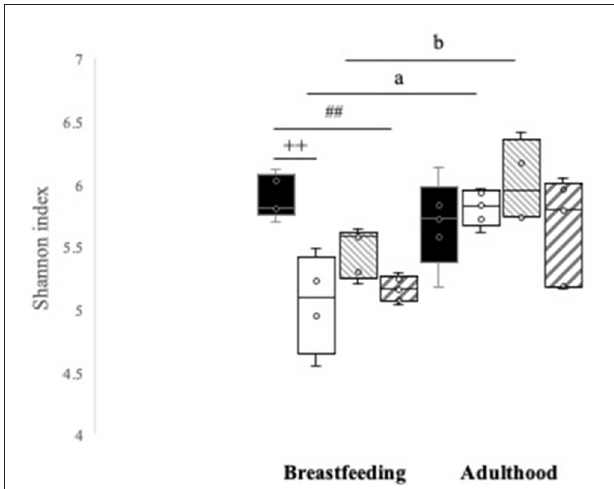
FIGURE 7 | Maternal high-sweeteners diet modifies the gut microbiota diversity by Shannon index. All the results are expressed as relative abundance (%) of sequences and presented as mean ± SEM. Control-C, HS-C, Ho-C, HSt-C. Statistical analyses were performed using one-way ANOVA and Dunnett’s test post-hoc or Kruskall Wallis non-parametric equivalent test. Differences of means per group between the two periods were analyzed by T -test for related samples. Control-C ( n = 5), HS-C ( n = 5), Ho-C ( n = 4), HSt-C ( n = 5). ++ p < 0.01 (Control-C vs. HS-C); ## p < 0.01 (Control-C vs. HSt-C); a p < 0.05 (HS-C); b p < 0.05 (Ho-C).